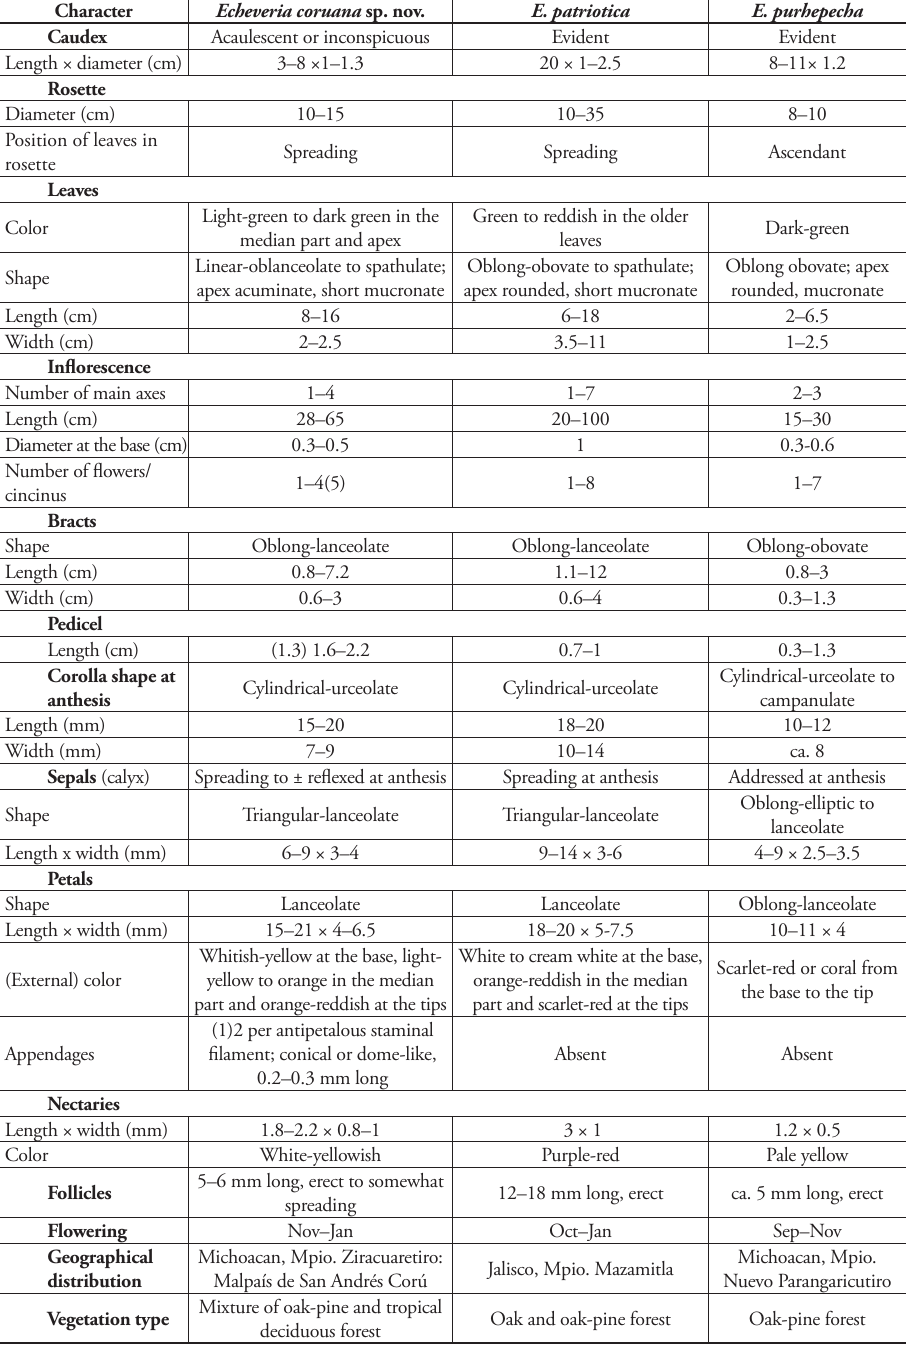
Table 1. Comparative morphology of Echeveria coruana with E. patriotica (García and Pérez-Calix 2007) and E. purhepecha (García 2011); “—“ indicates data not available for